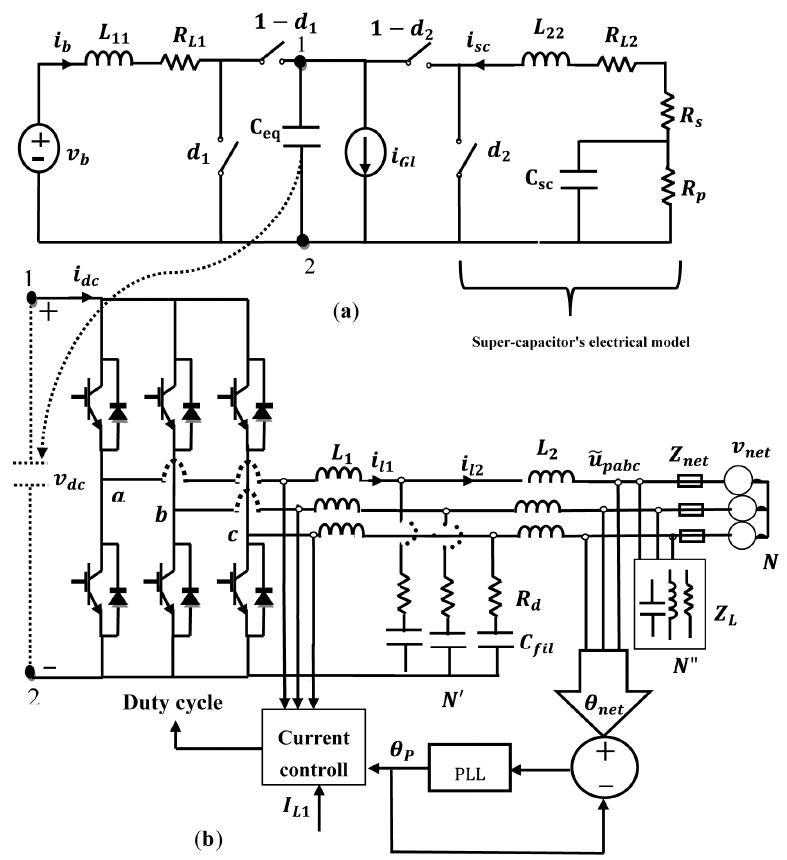
Figure 1. Schematic of studied micro-grid: ( a ) the hybrid storage system and equivalent circuit of micro-grid ( b ) network-interface converter and local load.